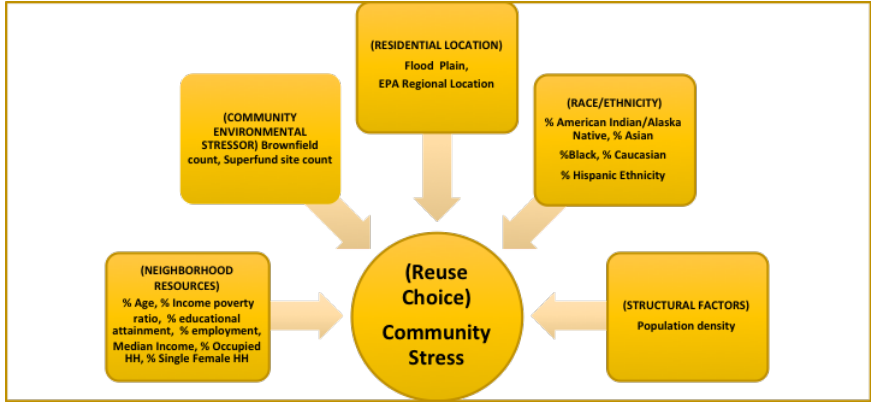
Figure 1. Community-Level Vulnerability: An Exposure–Stress Model (modified from Gee, Payne- Sturges, 2004).